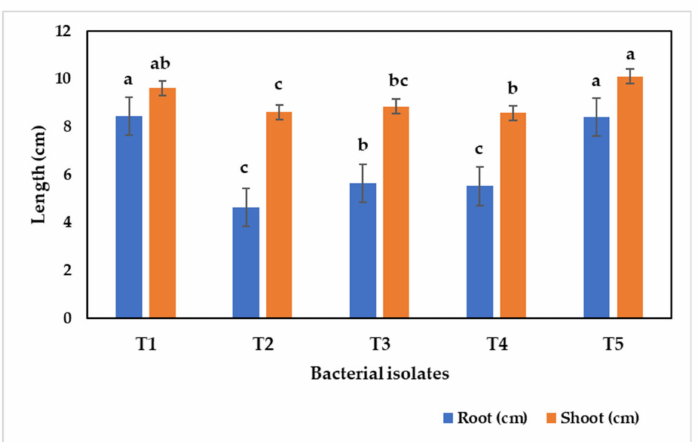
Figure 7. Impact of EPS-producing sodic-tolerant bacterial inoculation in rice on the plant growth and total dry weight and sodium absorption under sodic stress conditions. Each panel represent the mean of five replicates and the error bar indicates the standard error. The panels with the same letter are not significantly different as determined by the Tukey test ( p < 0.05). T1—absolute control; T2— Bacillus rugosus L1C7T; T3— Bacillus paralicheniformis L1C5L; T4— Pseudomonas sp. L5C14T; T5— Franconibacter helveticus L2C1T2.